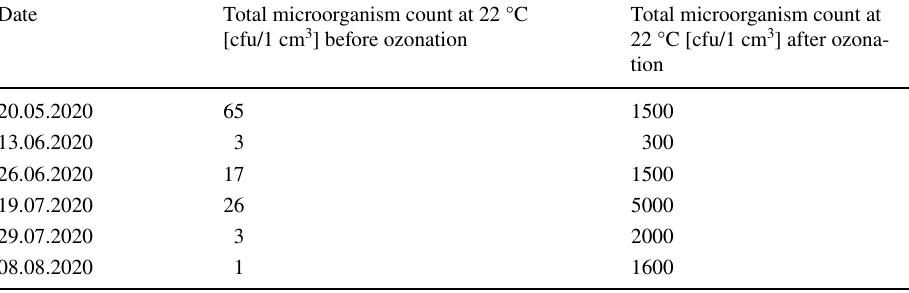
Table 4 Comparison of microorganisms in water before and after ozonation with a dose of 1.5 mg/dm 3